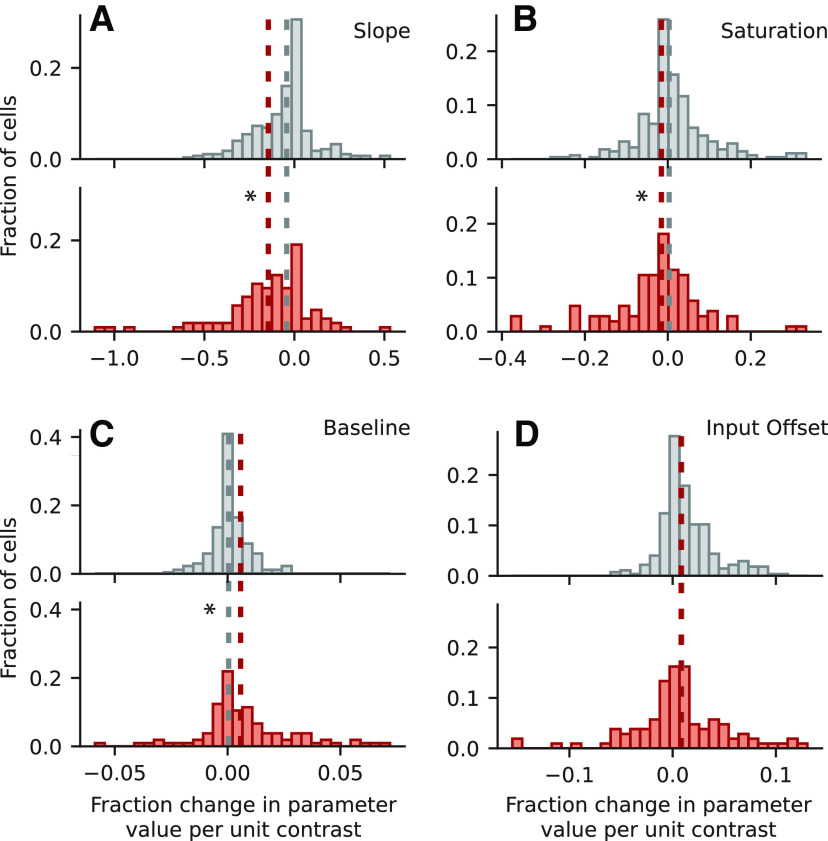
Parameter fit values for the GC model. A, Histogram of effect of contrast on k, representing the slope of the output nonlinearity, plotted for non-improved neurons (gray, top) and improved neurons (red, bottom) as in Figure 7. The negative median value for improved (−0.14) cells indicates a decrease in slope during high-contrast conditions. This median was significantly more negative than for non-improved neurons (−0.042, p = 1.22 × 10−4, two-sided Mann–Whitney U test). Asterisk indicates p < 0.05. B, Histogram of contrast effect on a (saturation level), plotted as in A. Median values for non-improved (0.0031) and improved (−0.0156) neurons were significantly different, indicating a decreased response amplitude in high contrast conditions (p = 8.01 × 10−6). C, Histograms of contrast effect on b (baseline of the output nonlinearity). Medians for non-improved (0.0005) and improved (0.0058) neurons were significantly different, indicating an increase in baseline for high contrast (p = 5.90 × 10−7). D, Distribution of contrast effect on s (input offset). There was no significant difference between medians for non-improved (0.0088) and improved (0.0082) neurons (p = 0.85).